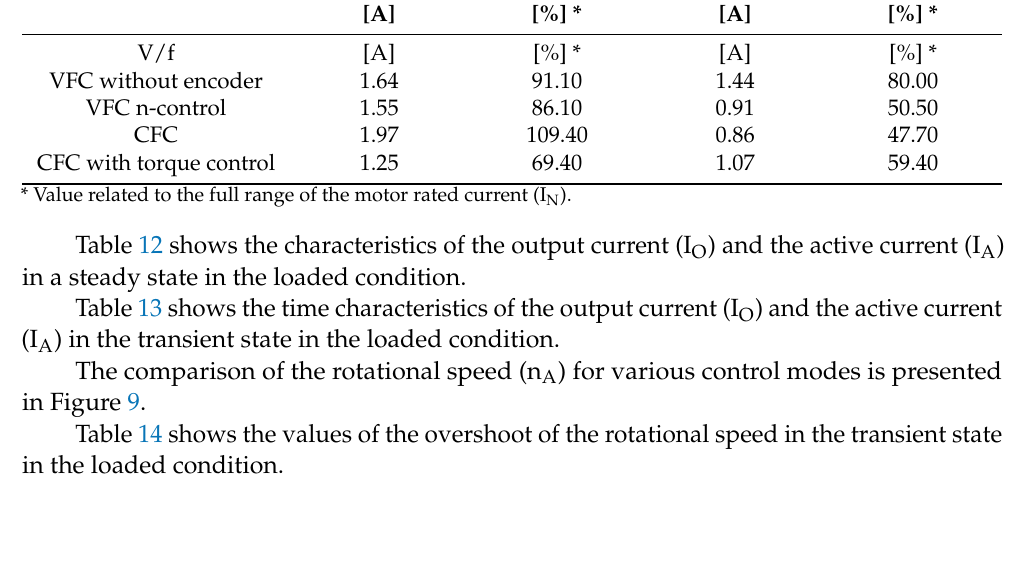
Table 11. Peak values of the output current (I O ) and the active current (I A ) of the frequency converter in a transient state (with the external load).